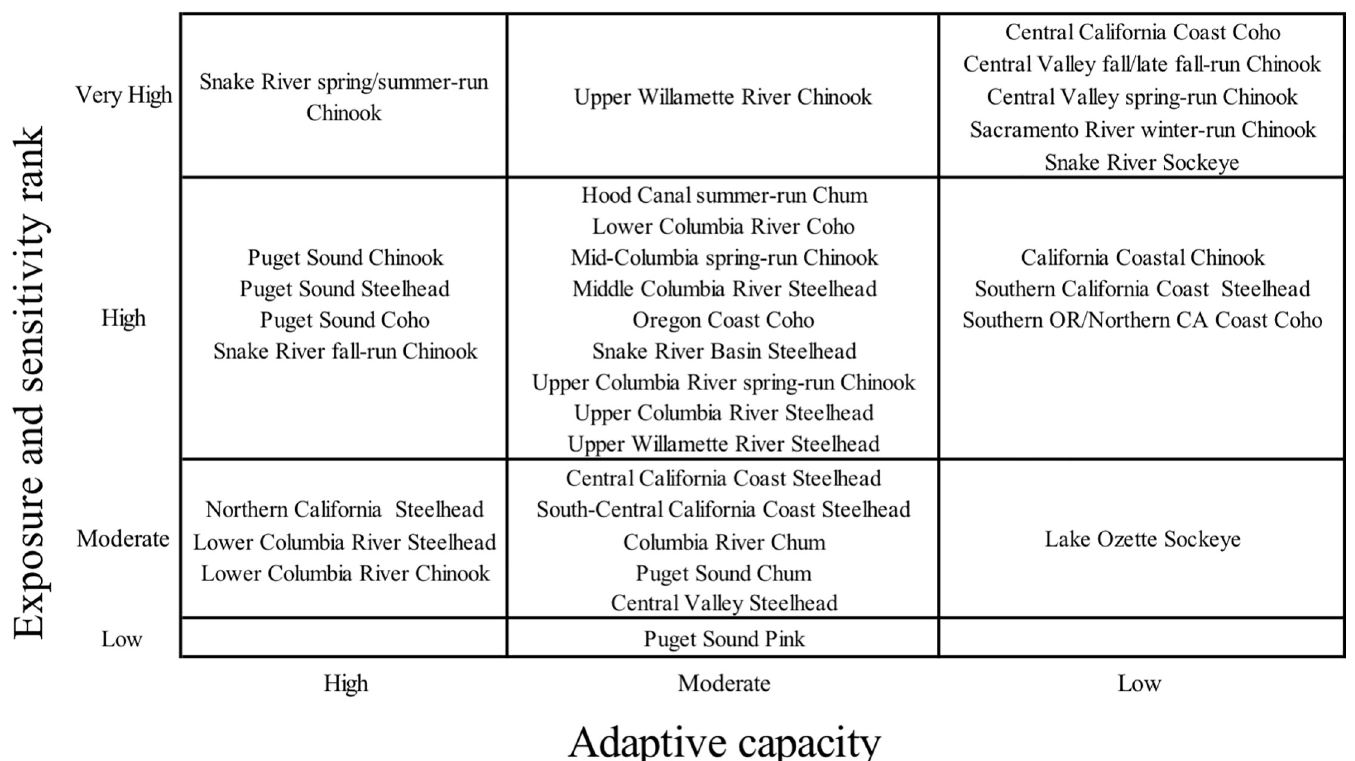
Fig 5. Adaptive capacity rank plotted against vulnerability rank. Vulnerability ranks were determined by exposure and sensitivity attributes (Fig 3). Adaptive capacity attribute scores reflected the opportunity perceived by scorers that some trait change would help mitigate the negative effects of climate change.